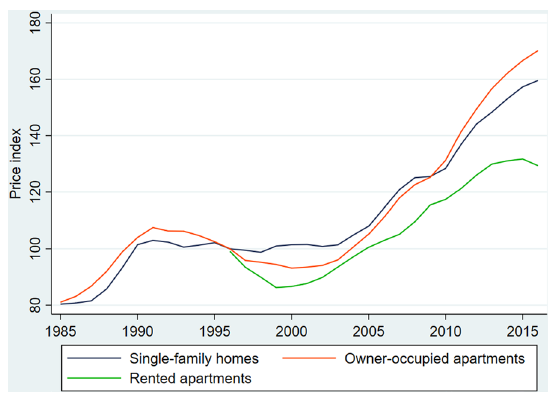
Fig. 1 Price indices for single-family homes, owner-occupied apartments and rented apartments in Switzerland, 1985–2016. Notes: Base year 1996. Aggregate data for entire Switzerland. Source: Own = calculations based on data from Wüest